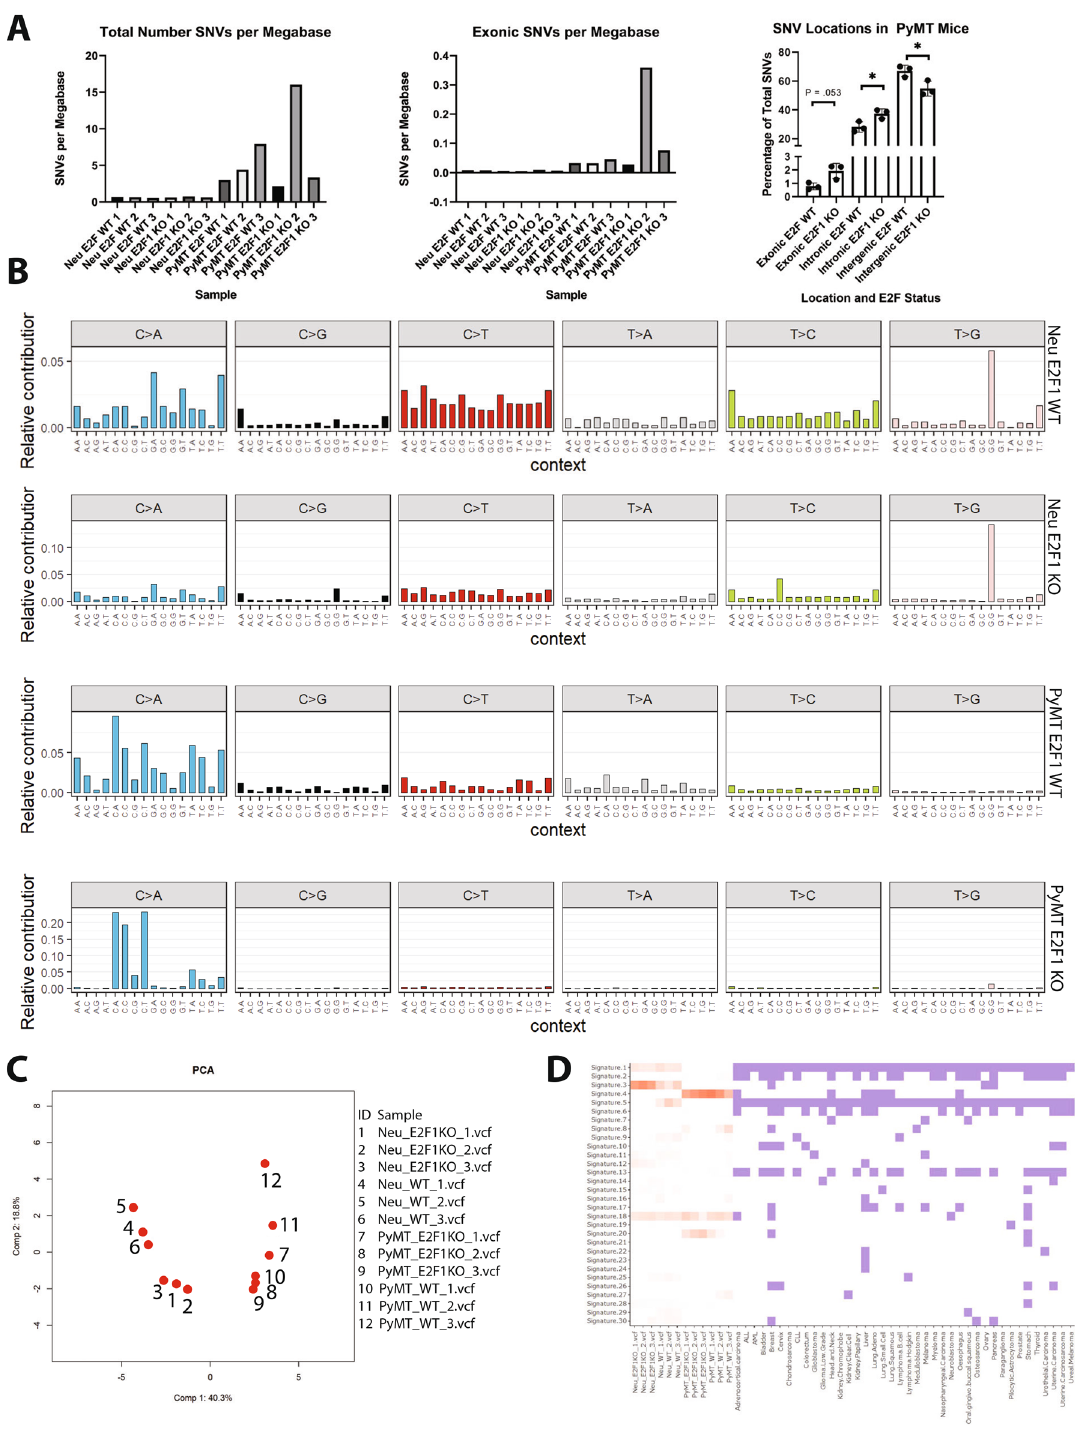
Figure 4. SNV mutation burden in Neu and PyMT tumors. ( A ) Bar graphs represent the number of total or exonic mutations per megabase occurring in all 12 sequenced tumors. ( B ) Shows representative mutation profiles for each of the four classes of samples sequenced. Mutation profiles are derived from 96 bp trinucleotide signatures originally developed by Alexandrov et al. Four classes of samples are Neu E2F1 +/+ , Neu E2F1 −/− , PyMT E2F1 +/+ , PyMT E2F1 −/− . ( C ) PCA plots derived from trinucleotide signatures show clustering of all 12 samples sequenced. ( D ) The heatmap of cancer signatures for the 12 sequenced tumors, as well as various cancers is